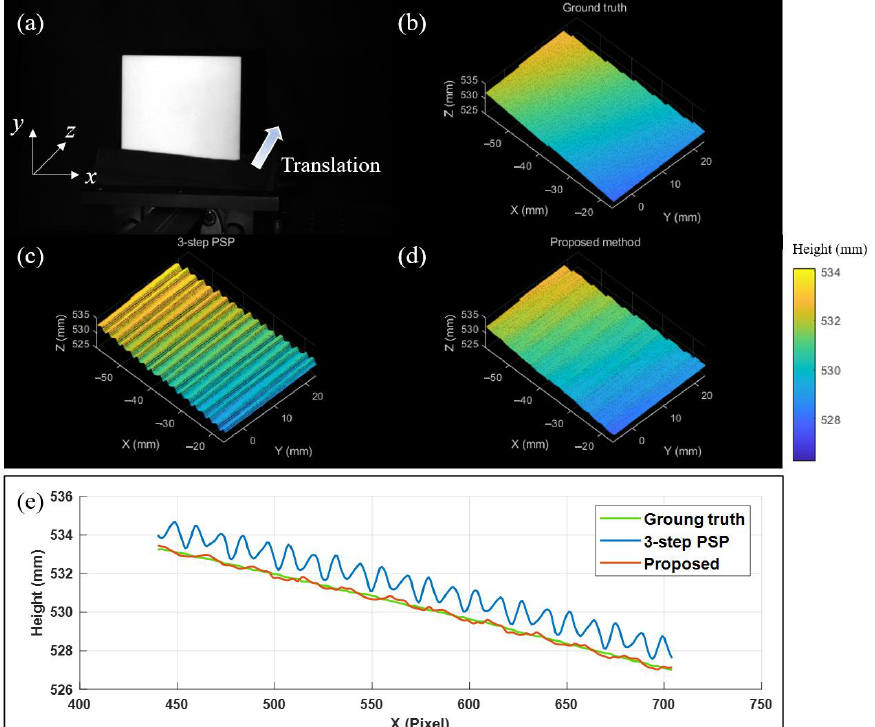
Figure 6. Measurement results of a translational scene in actual FPP system. ( a ) Standard ceramic plate translated in depth direction to be tested. ( b – d ) Reconstructed results of 12-step PSP, three-step PSP and proposed method, respectively. ( e ) Section line in 600th row of the height (Z) distributions of three methods.